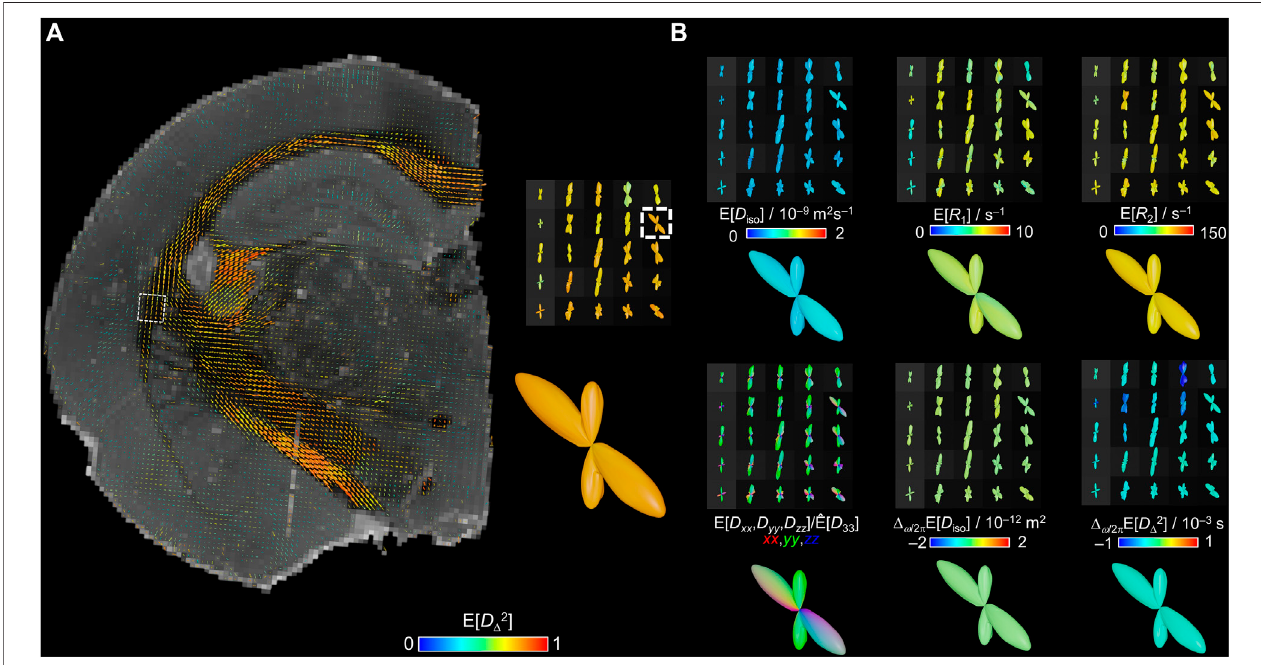
FIGURE 6 | Per-voxel ODFs of the bin1 fraction. The ODFs are obtained from the per-voxel D( ω )- R 1 - R 2 distributions by mapping the bin1-component weights w , orientations( θ , ϕ ),and parameters D iso , D Δ 2 , R 1 , R 2 , D xx ,D yy ,and D zz ontoaspherical meshusinga10 ° sphericalGaussianconvolution kernel fortwofrequencies ω /2 π (cid:2) 50and150 Hz.ODFradiiaregivenbytheorientation-resolvedmeanweightswhilethecolorsderivefromtheorientation-resolvedmeanparametersusingthesamecolor schemeasinthe Figure3D . (A) E[ D Δ 2 ]-coloredODFs displayed overasynthetized R 2 - weightedimage calculated fromthe per-voxel D ( ω )- R 1 - R 2 distributions with Eq. 1 using b (cid:2) 0, τ R (cid:2) ∞ , and τ E (cid:2) 20 ms. A closer view on one voxel reveals two distinct fi ber populations with similar values of E[ D Δ 2 ]. (B) ODFs colored by E[ D iso ], E[